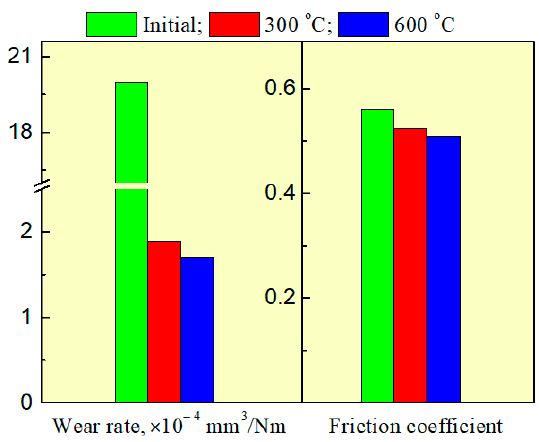
Figure 37. Results of tribological studies.